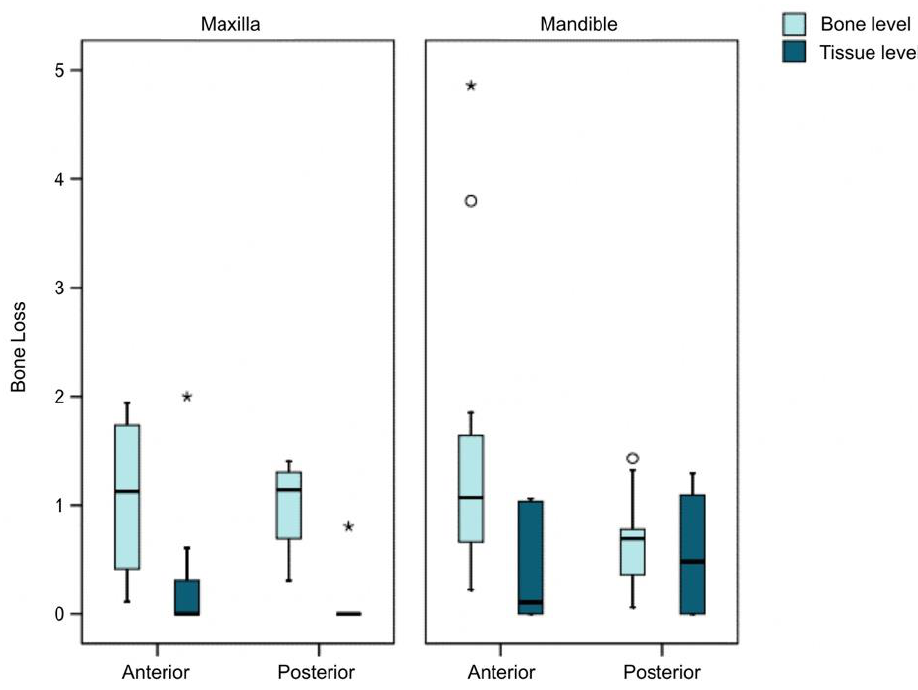
Figure 11. Bone loss according to implant type and position in the arch in FPP. * major outlier ◦ minor outlier.